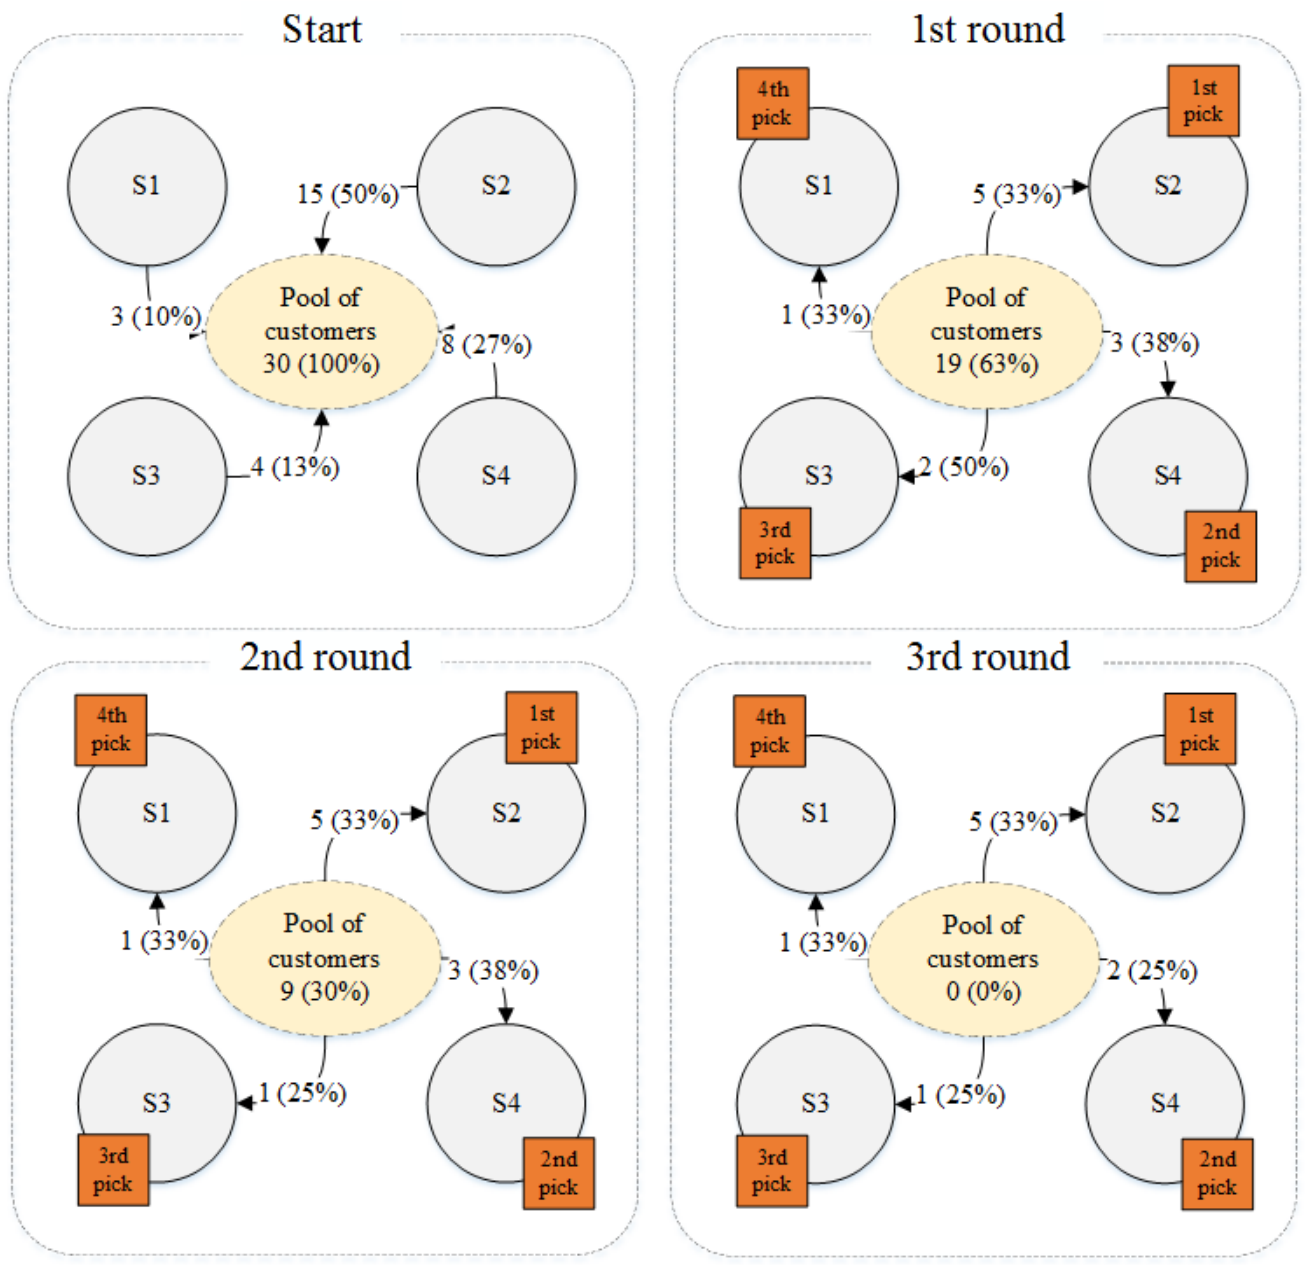
Figure 6. Example of the limited cooperation